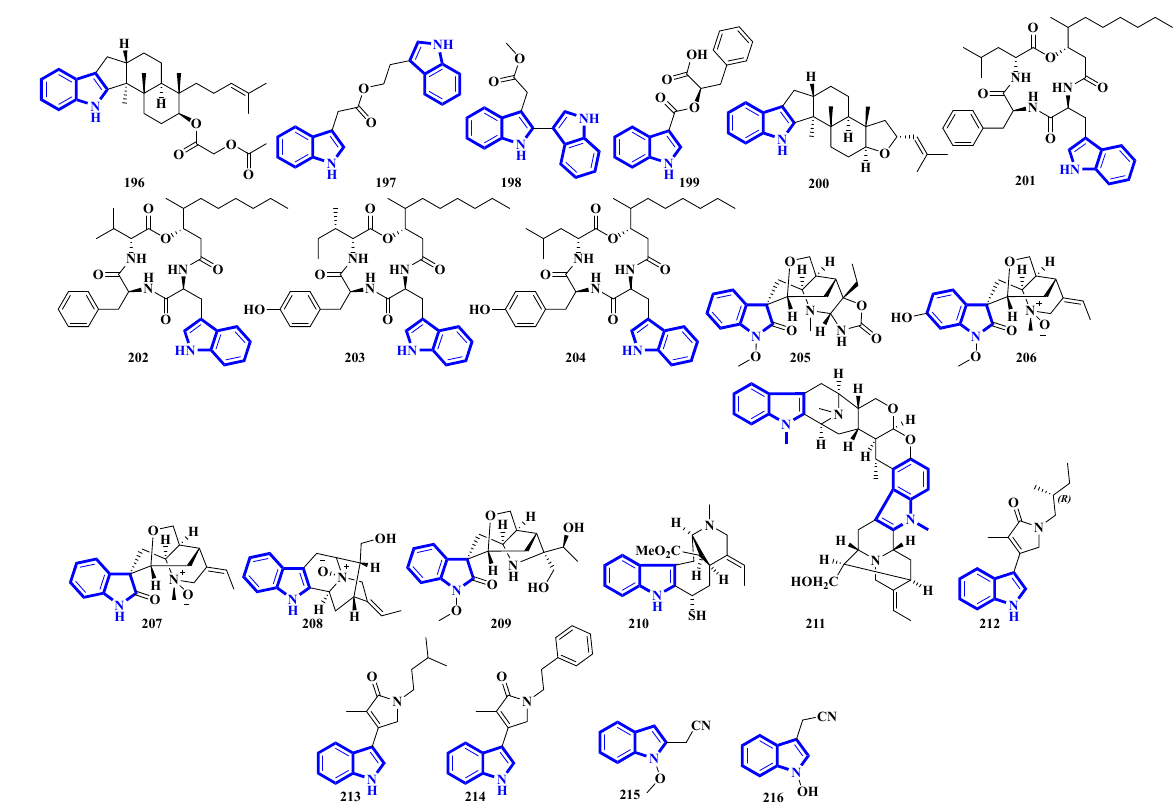
Figure 10. Novel indole alkaloids 196 to 216 . Compounds 217 to 228 are novel [11]-chaetoglobosins isolated from Pseudeurotium bakeri , obtained from macrocoma moss (family: Orthotrichaceae). The alkaloids, containing an 11-membered macrocyclic ring, represent a rare motif as only seven naturally occur- ring [11]-chaetoglobosins have been reported [63]. Compound 229 is a novel indole-linked 2,5-diketomorpholine alkaloid with an unprecedented 6/5/6/6/5 core, while compound 230 contains an indole fused with pyrrole and possesses a 6/5/5 core [64]. Compounds 231 and 232 were isolated from the bark of Voacanga africana , and they are the first monoter- pene trisindole alkaloids containing a vobasine–aspidosperma–aspidosperma skeleton [65]. Similarly, compound 233 is the first methylenedioxy dibromoindole alkaloid exhibiting antiosteoporosis activity [66]. Additionally, compound 234 is a dibrominated β -carboline sulfamate, one of the only 11 indole sulfamate-containing marine natural products re- ported in the Marin Lit. database [67]. Compounds 235 and 236 were products of the heterologous expression of the EDB gene cluster (found in P. fluorescens NZI7) in E. coli . The metabolites are isoindoles containing an ethanol group [68]. Compounds 237 and 238 were isolated by processing the whole Ophiorrhiza japonica plant representing two novel glycosides [69]. Compounds 239 to 244 are notoamide-type alkaloids isolated from Aspergillus sclerotiorum , extracted from a gorgonian coral. Compounds 239 and 240 possess a unique 2,2-diaminopropane group, while compounds 241 and 242 are novel notoamide hybrids having a coumarin moiety. Compound 244 is a new highly oxidized notoamide scaffold [70]. Compounds 245 to 248 are indole-C-mannopyranoside alkaloids: rare in- dole C-glycosides in which an α -D-mannose residue is connected to the indole ring at C-2 [71]. Compounds 249 and 250 are diterpenoid indole alkaloids isolated from Penicillium oxalicum obtained from the mantis shrimp, Oratosquilla oratoria . Compound 249 is the first indole-diterpenoid derivative with a 4-hydroxy-5,5-dimethyldihydrofuran-3-one as a side-chain (6/5/6/5/5/6/6-5 system). Compound 250 is a hemiketal containing a unique 6/5/6/5/5/6/6/5/5 ring system (Figure 11)